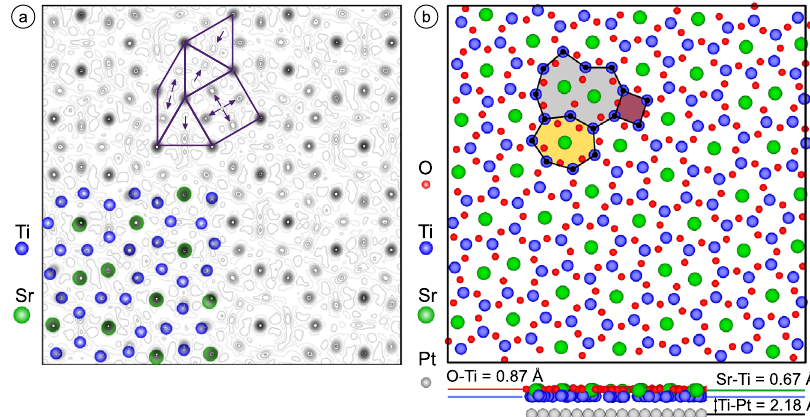
Fig. 2 | Atomic structure of the 48:18:6 approximant. a SXRD-derived electron density map calculated from the best fi t model for the unit cell of the 48:18:6 approximantinSr-Ti-OonPt(111).TheheavySratoms(green)resideatpositionsof the highest electron densities.Byconnecting the Sratomsthe tiling seen in STM is formed (emphasized in the upper part). The weaker electron densities are attrib- uted to Ti atoms (blue). Their positions inside the tiling elements are marked by